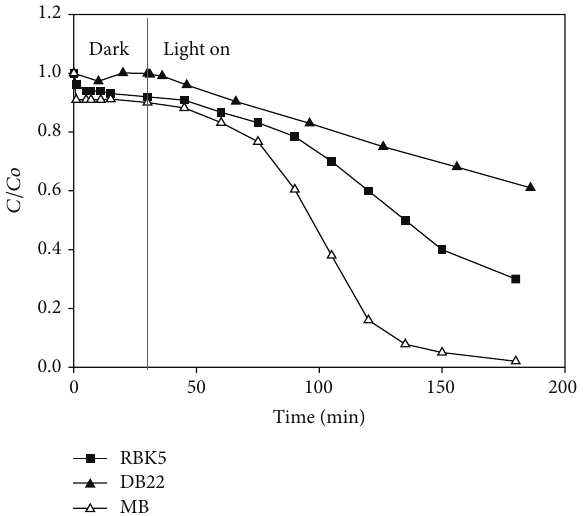
Figure 7: The effect of dye species on degradation efficiency under 254 nm UV and 1.13% Fe TNT of 0.04 gL −1 .